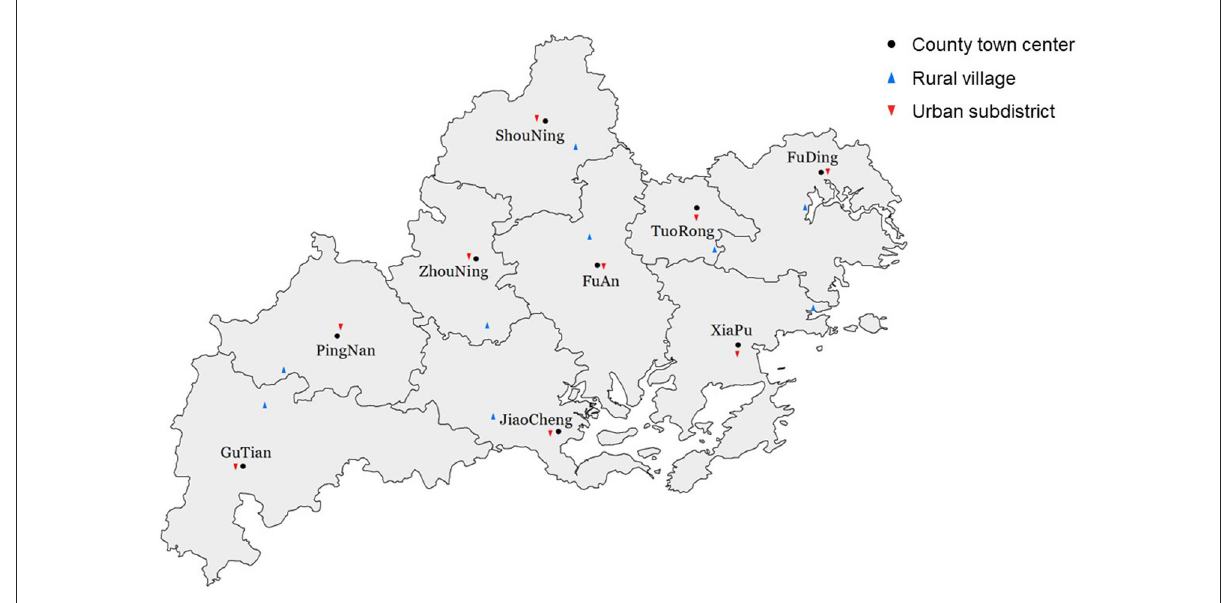
FIGURE1 Sampling sites of the present